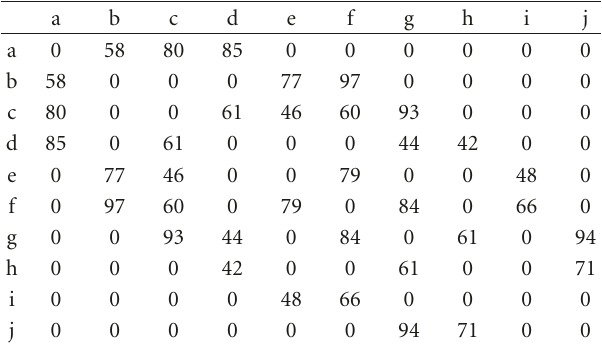
Figure 11: Marginal distribution of labeling variable in inference with 1-order spatiotemporal model. The 3rd, 10th, 23rd, and 25th observations are missed, depicted as dashed column. The true labels are depicted by stars. Each column represents the marginal distribution of the label of an observation. Grayscale corresponds to probability value. Black represents probability 1, and white probability 0. (a) Forward exact. (b) Forward approximate I. (c) Forward approximate II. (d) Backward exact. (e) Backward approximate I. (f) Backward approximate II. Table 1: The mean travel time between adjacent